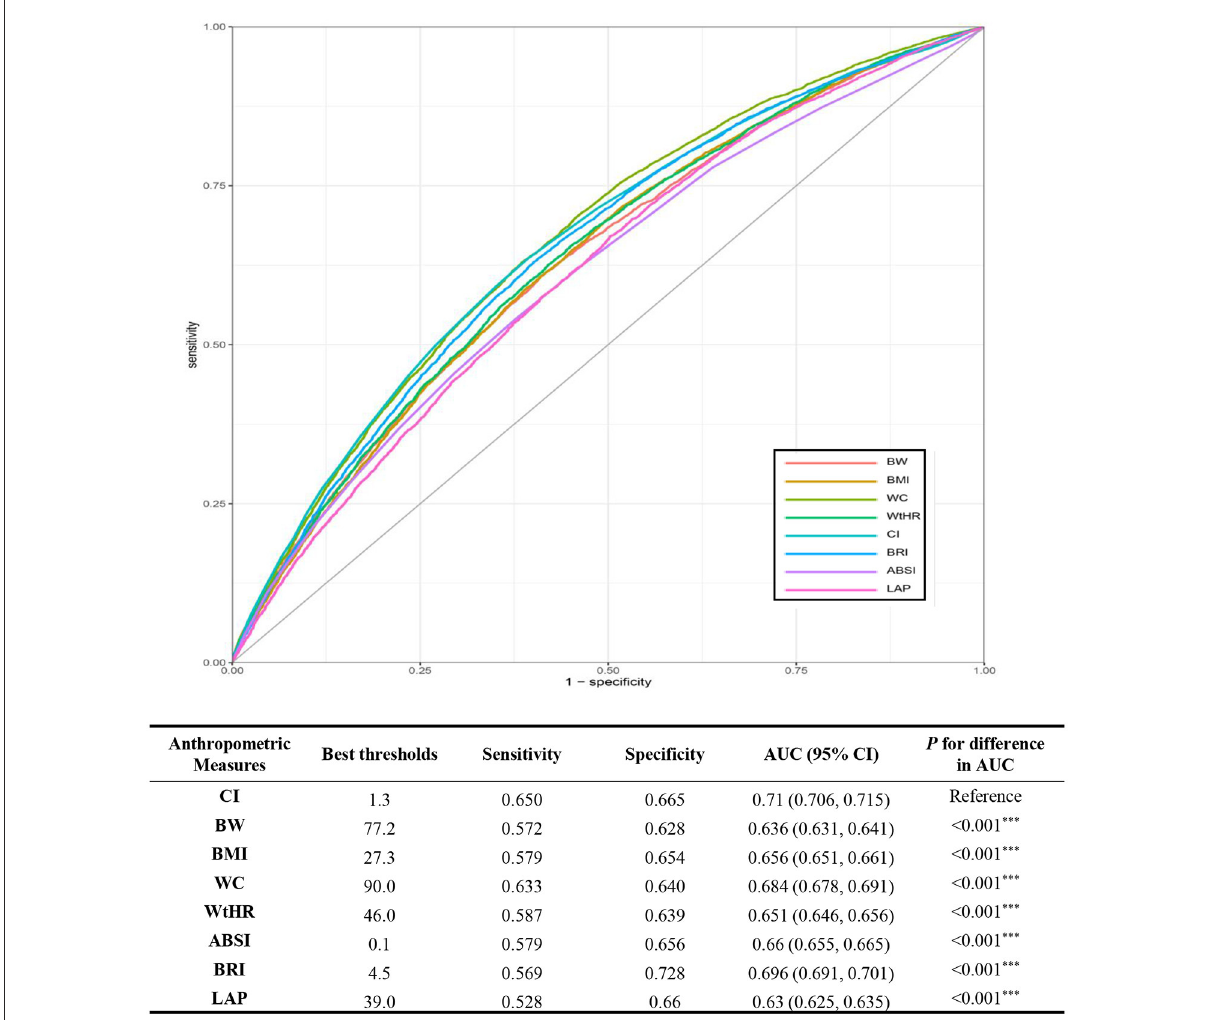
FIGURE3 ROC curves of anthropometric indices for discriminating hypertension. ROC, receiver operating characteristic; AUC, area under the curve; BW, body weight; BMI, body mass index; WC, waist circumference; WtHR, waist-to-height ratio; CI, conicity index; ABSI, a body shape index; BRI, body round index; LAP, lipid accumulation